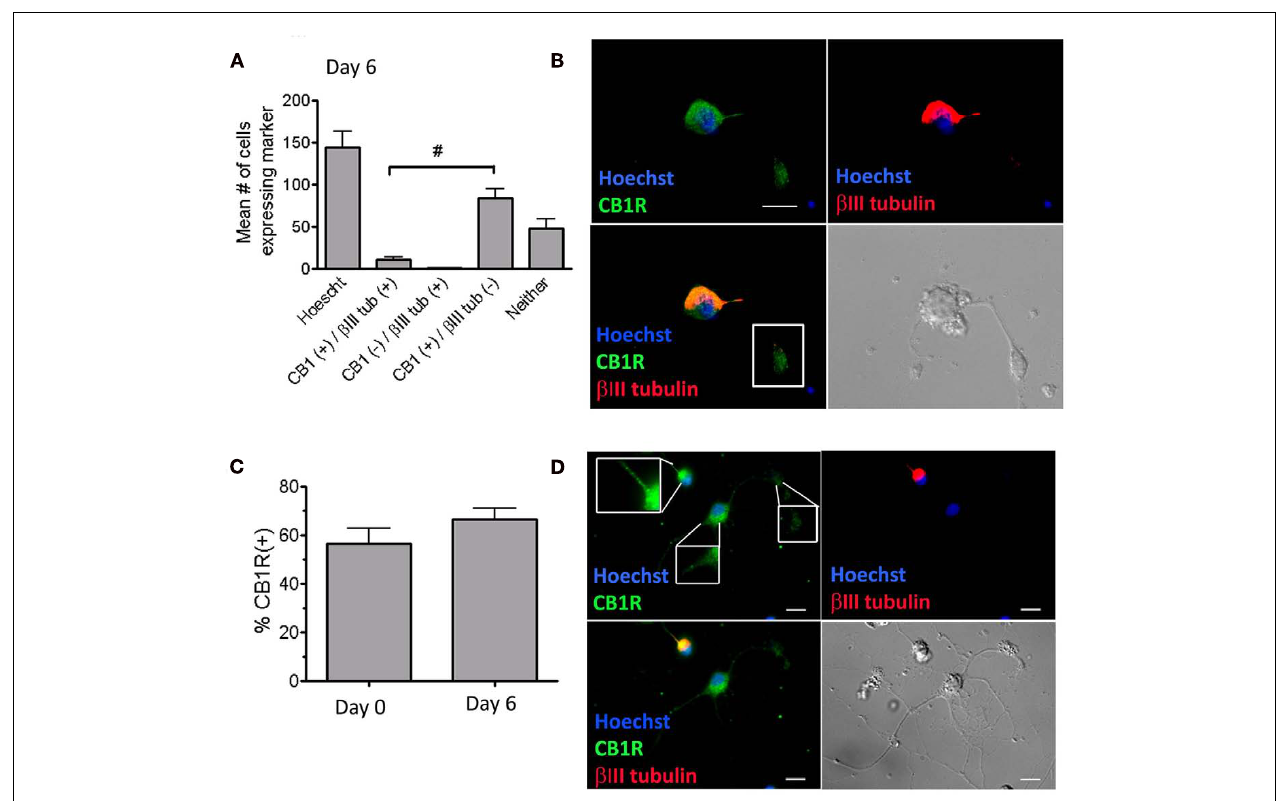
the% of CB1R( + ) between Day 0 and Day 6 (Unpaired t -test, two tailed). Twenty fields were analyzed per coverslip ( n = 3 coverslips; mean + SEM). (D) This image shows one cell that is CB1R( + )/ β III tubulin( + ) (immature neuron) and another cell that is CB1R( + )/ β III tubulin( − ) (which based on morphology could represent a mature neuron).The insets in the upper left panel (starting from the most left inset, and going in a clockwise direction) magnify the CB1R expression on the soma/extension of the immature neuron, the terminal of the mature neuron, and the soma/extension of mature neuron. In all cases the background fluorescence was subtracted from the image relative to the negative control, the nuclei were labeled with Hoechst 3392 (blue). (B,D) Images were acquired with a 63 × objective; scale bars = 10 μ